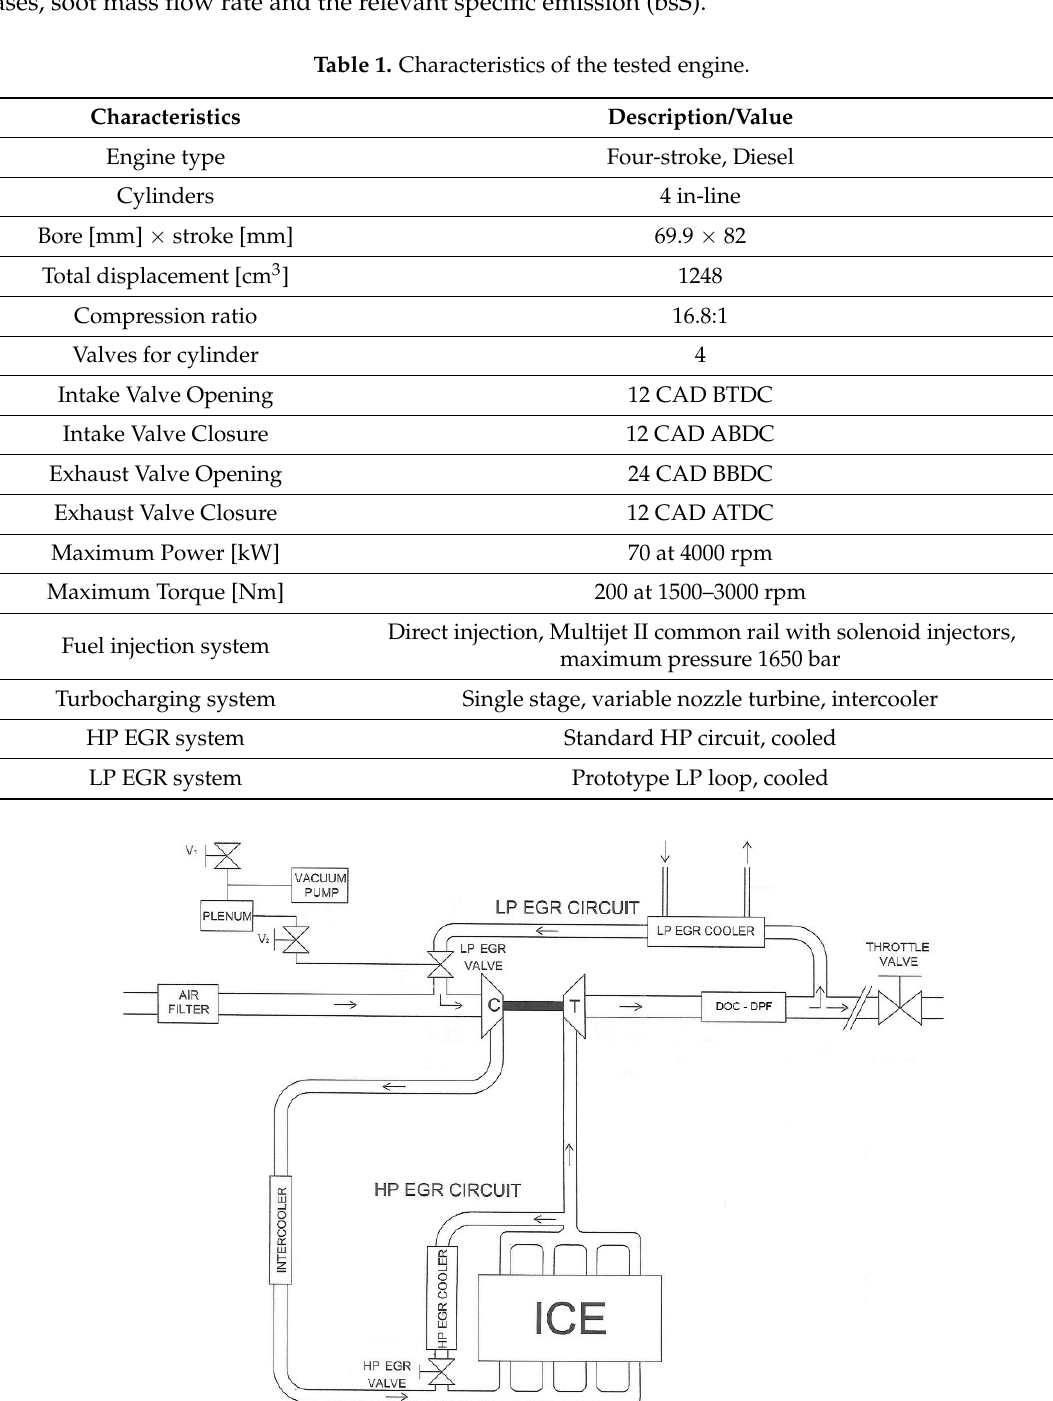
Figure 1. Scheme of the tested engine [1].